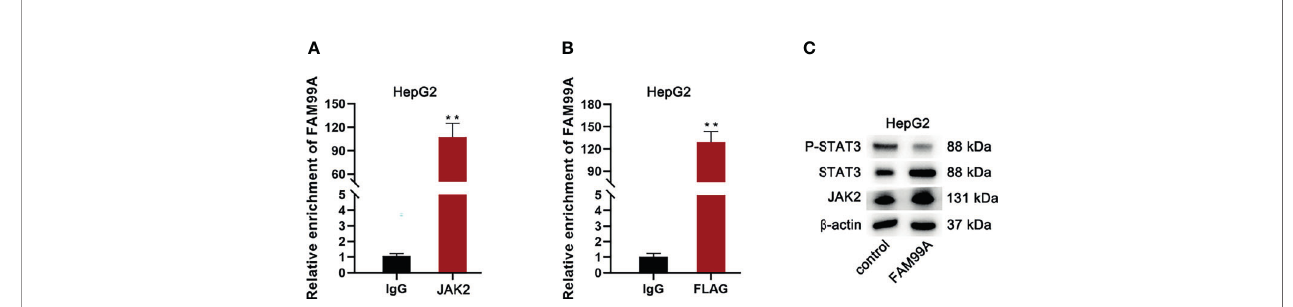
FIGURE 7 | FAM99A inhibited STAT3 phosphorylation to affect the JAK2/STAT3 activity via binding to JAK2. (A) RIP and qRT-PCR assays were conducted to verify whether FAM99A could bind to JAK2. (B) We adopted RIP and qRT-PCR assays to verify whether FAM99A could bind to FLAG with the JH1 catalytic domain. (C) Western blotting assay was conducted to detect the effect of FAM99A on phosphorylated STAT3. ** p <